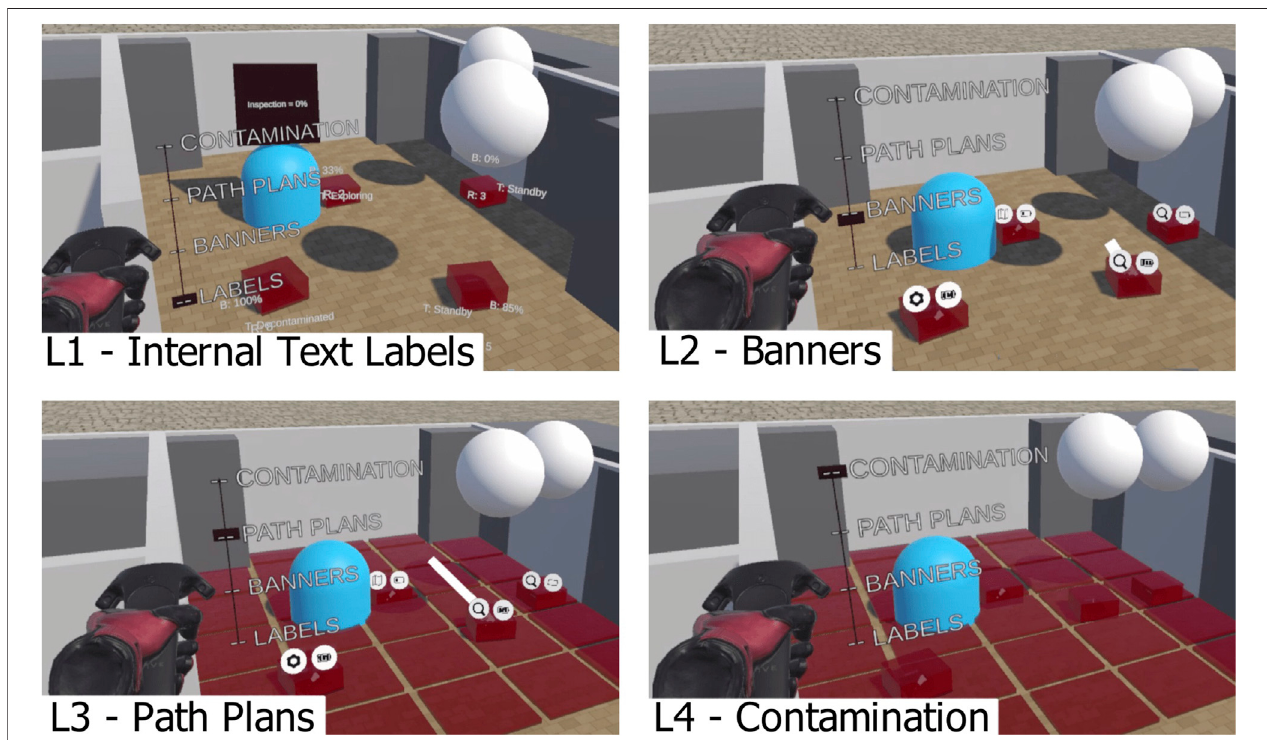
FIGURE 5 | The four layers ofinformation displayed. L1 istextual labels displayinginternal information about the robot (e.g. task being performed). L2 has banners displaying external information about the robot (e.g. type of robot). L3 displays lines that represent the planned paths of each robot. L4 displays “ contaminated ” areas within the